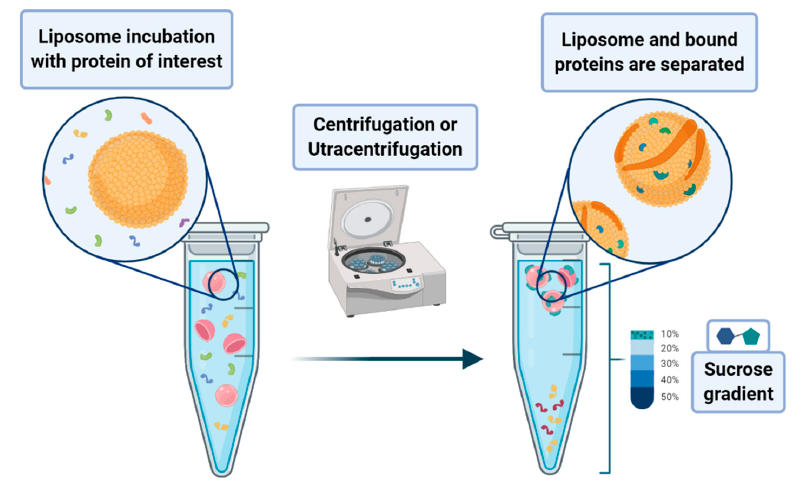
Figure 17. Scheme of the liposome flotation assay. Liposomes are incubated with the proteins of interest to investigate the possible interaction of the analyte with the phospholipidic membranes. Liposomes are then separated by centrifugation or ultracentrifugation, usually in the presence of gradients. The presence of the protein in the liposome specimen suggests the occurrence of a protein–membrane interaction.